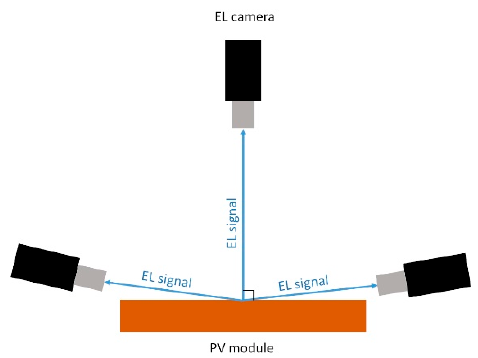
Figure 7. Electroluminescence test at different shooting angles.